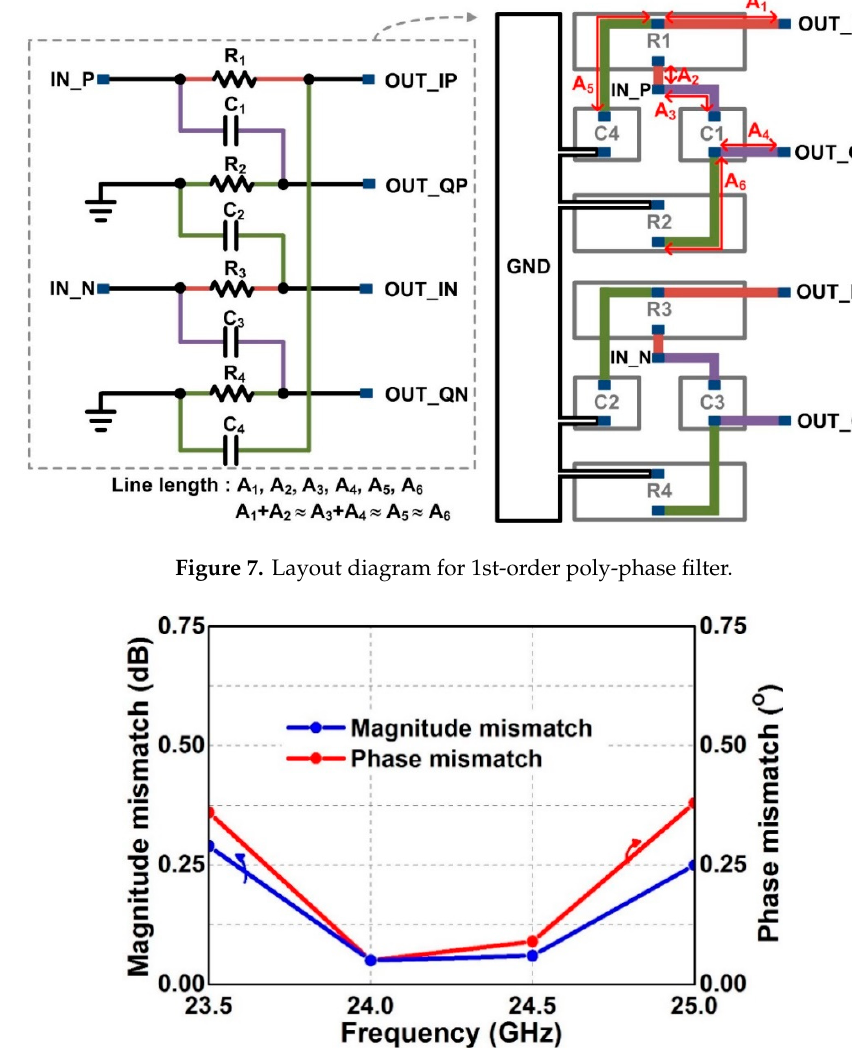
Figure 8. Simulated magnitude and phase mismatch between the I - and Q -paths of the proposed poly-phase filter-based I / Q LO generation circuits.